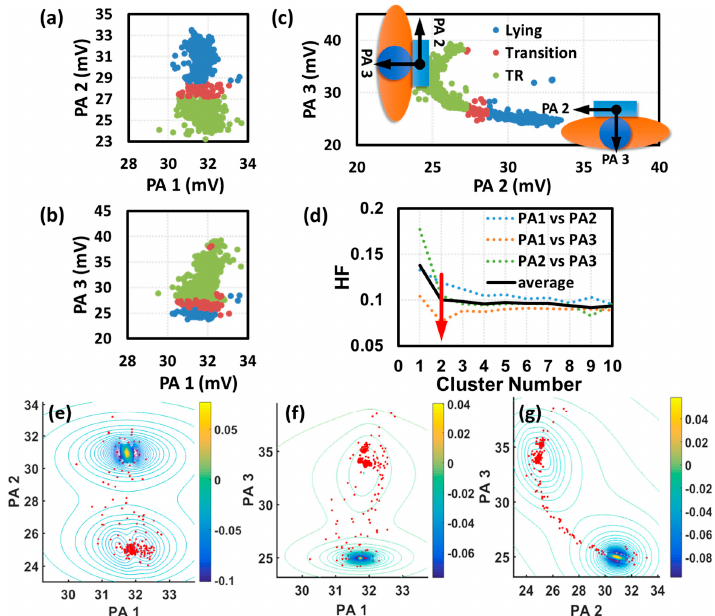
Figure 5. Estimation of a Lying-to-TR case using the proposed EEFM algorithm. The most probable states of the motional patterns in this studied case are lying, transition, and TR. The difference between Figures 4 and 5 is the direction of state migration in ( c ), and it is also a significant pattern feature for motional pattern recognition. ( a , b ) similarly show the insignificant mapped results from PA 1. The corresponding LDF morphologies are sequentially exhibited in ( e – g ).